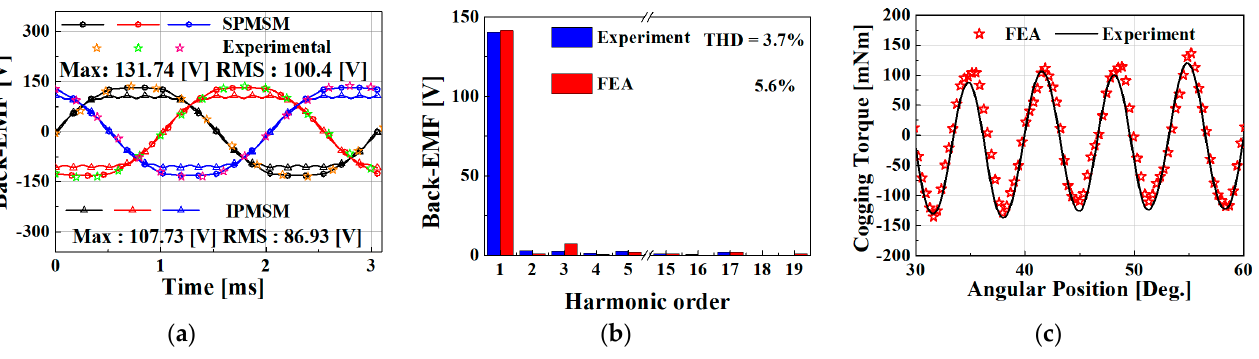
Figure 9. Experimental result: ( a ) back EMF; ( b ) back EMF FFT; ( c ) cogging torque .